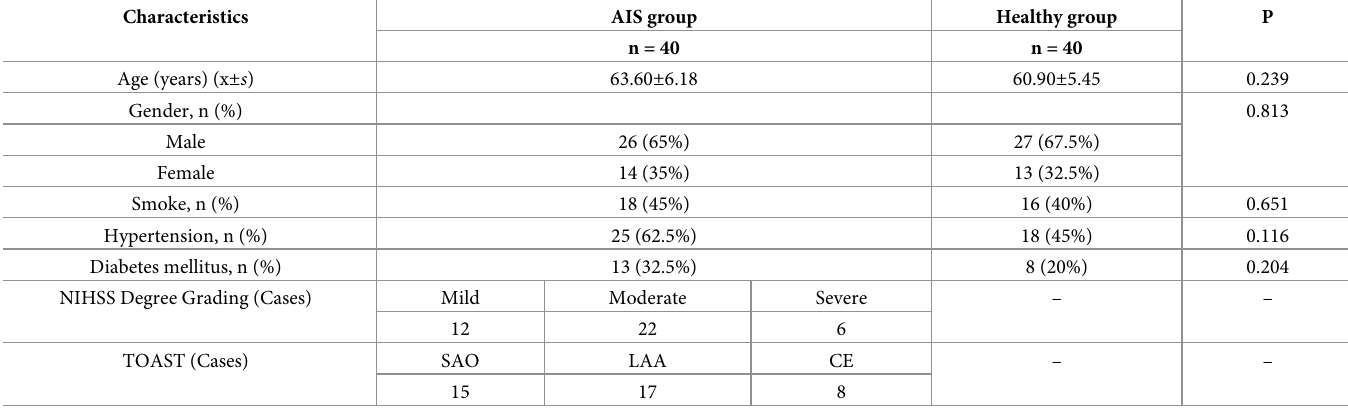
Table 2. Clinical data characteristics of the experimental group and control